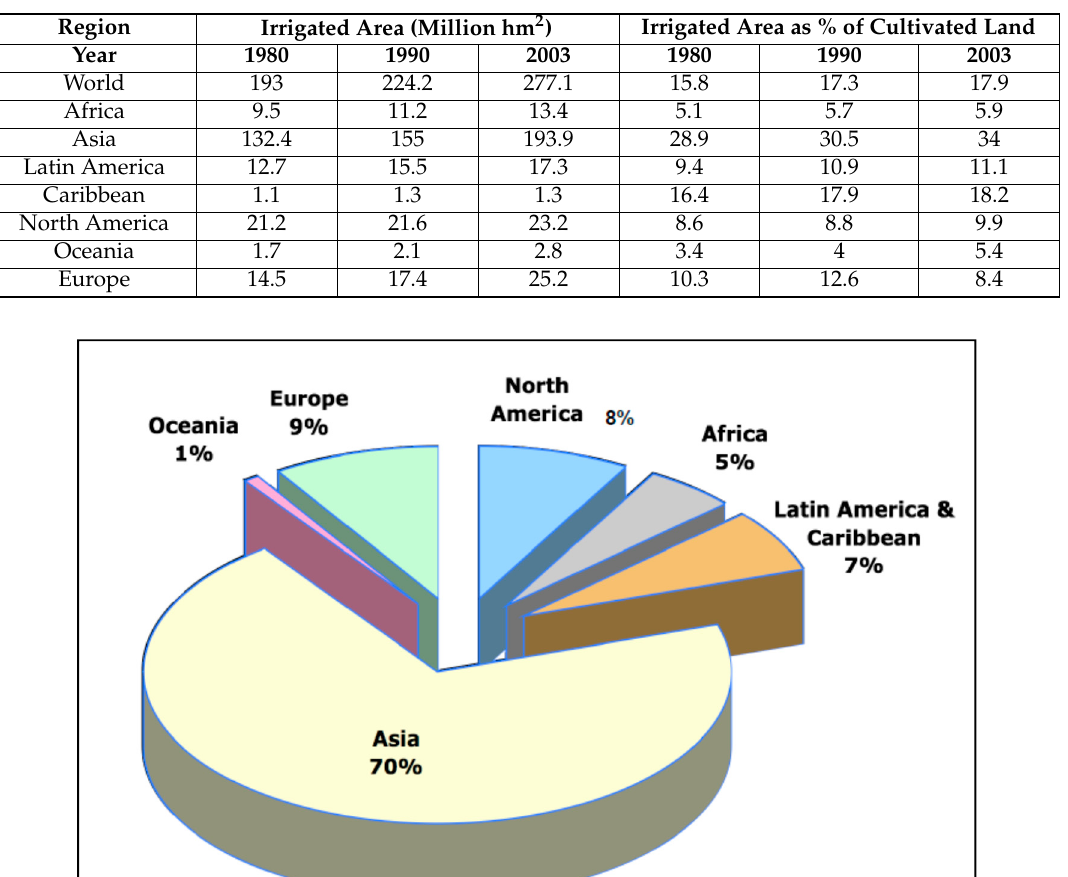
Table 2. Area equipped for irrigation and percentage of cultivated land for selected years (adapted from [160]).